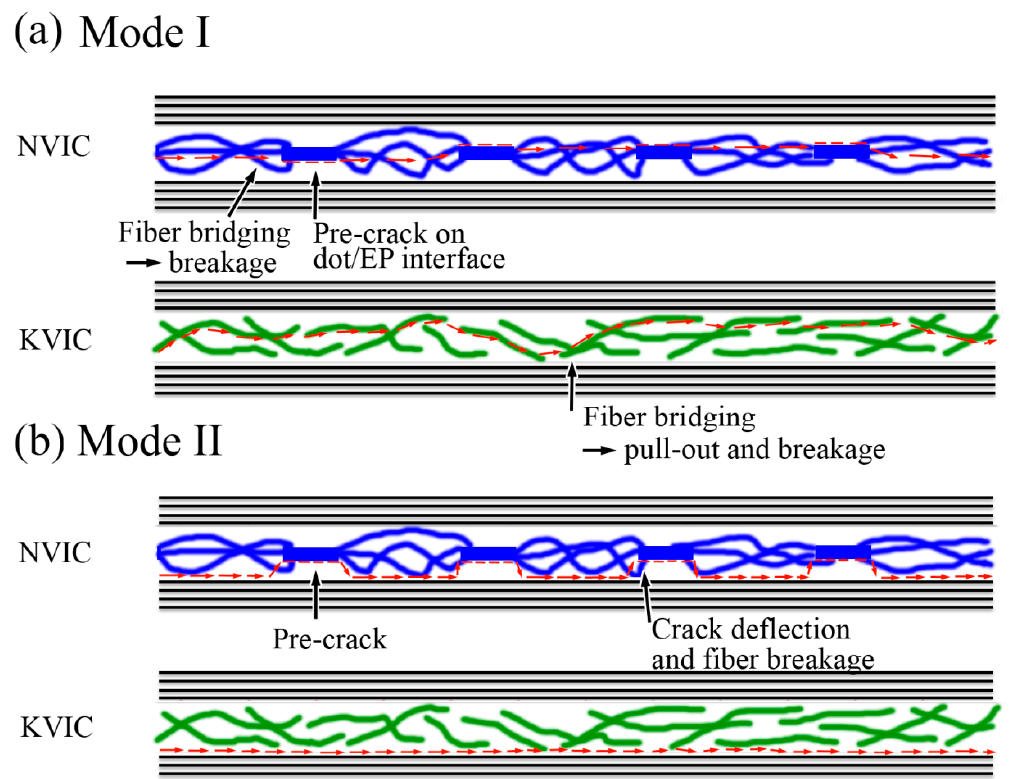
Figure 8. Sketch diagram of ( a ) Mode I and ( b ) Mode II fracture paths of the interleaved composites.